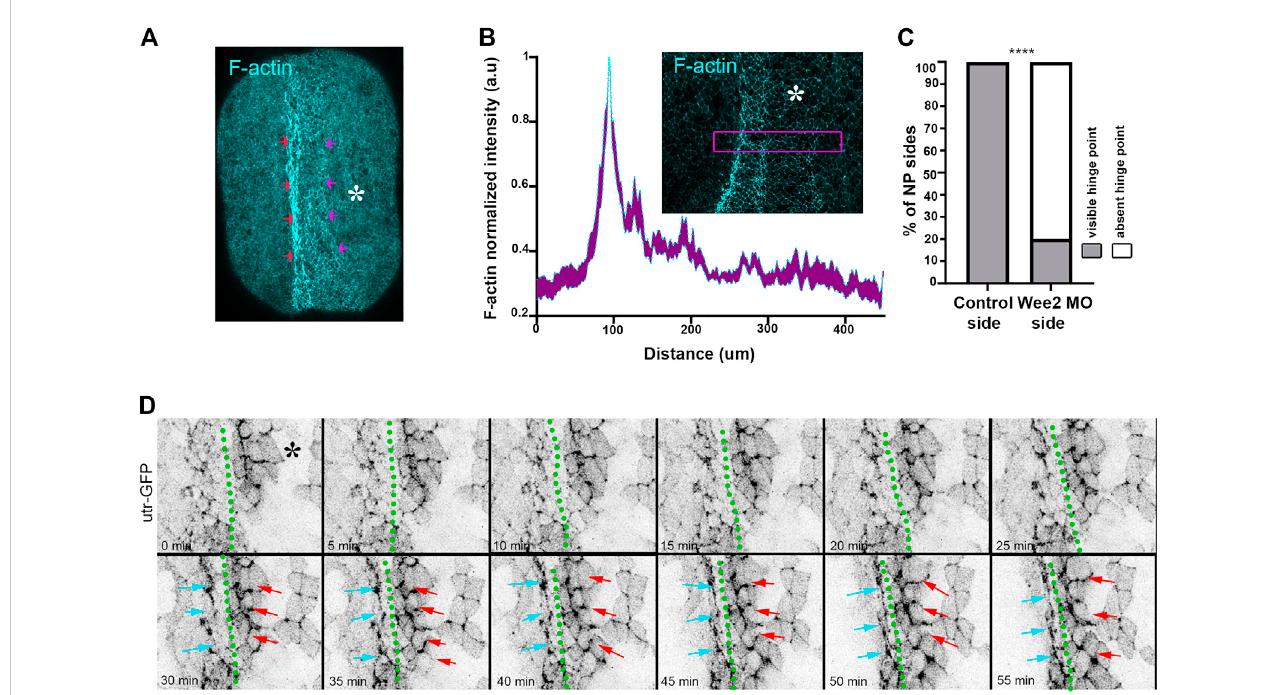
FIGURE 4 Hinge point formation depend on proper somitic mesoderm morphogenesis. (A) Dorsal view of a representative neurula stage 16 embryo stained with Phalloidin (F-actin). Red arrows: F-actin accumulation at the neural plate boundary denotes hinge point formation. Purple arrows: Hinge point formation is impairedattheneuralplatesideoverlyingWee2morphantsomiticmedoderm.Asterisk:SideoverlyingWee2morphantsomiticmesoderm.Scalebar:100 μ m (B) Normalized F-actin intensity pro fi le along the mediolateral neural plate axis. n = 10 embryos. Peak intensity indicates the position of the hinge point. Note that F-actin accumulation at the side overlying somitic mesoderm injected with Wee2 morpholino is impaired. Inset: Representative example of neural plate of an embryo with unilateral Wee2 morphant somitic mesoderm. Asterisk: Wee2 morphant side. Purple box was used to plot F-actin intensity pro fi le along the neural plate mediolateral axis. Scale bar: 100 μ m (C) Quanti fi cation of hinge point formation. χ 2 test; **** p < .0001 n = 15 embryos. (D) Stills from a time lapse recording of a neurula embryo expressing Utrophin GFP. Green dotted line: midline. Cyan arrows: Neural plate surface ectoderm boundary at the side overlying control somitic mesoderm. Red arrows: Neural plate/surface ectoderm boundary at the neural plate side overlying Wee2 morphant somitic mesoderm.F-actinaccumulationcharacteristicofhingepointformationoccursonlyattheneuralplate/surfaceectodermboundaryoverlyingcontrolsomitic mesoderm Scale bar: 50 μ m.